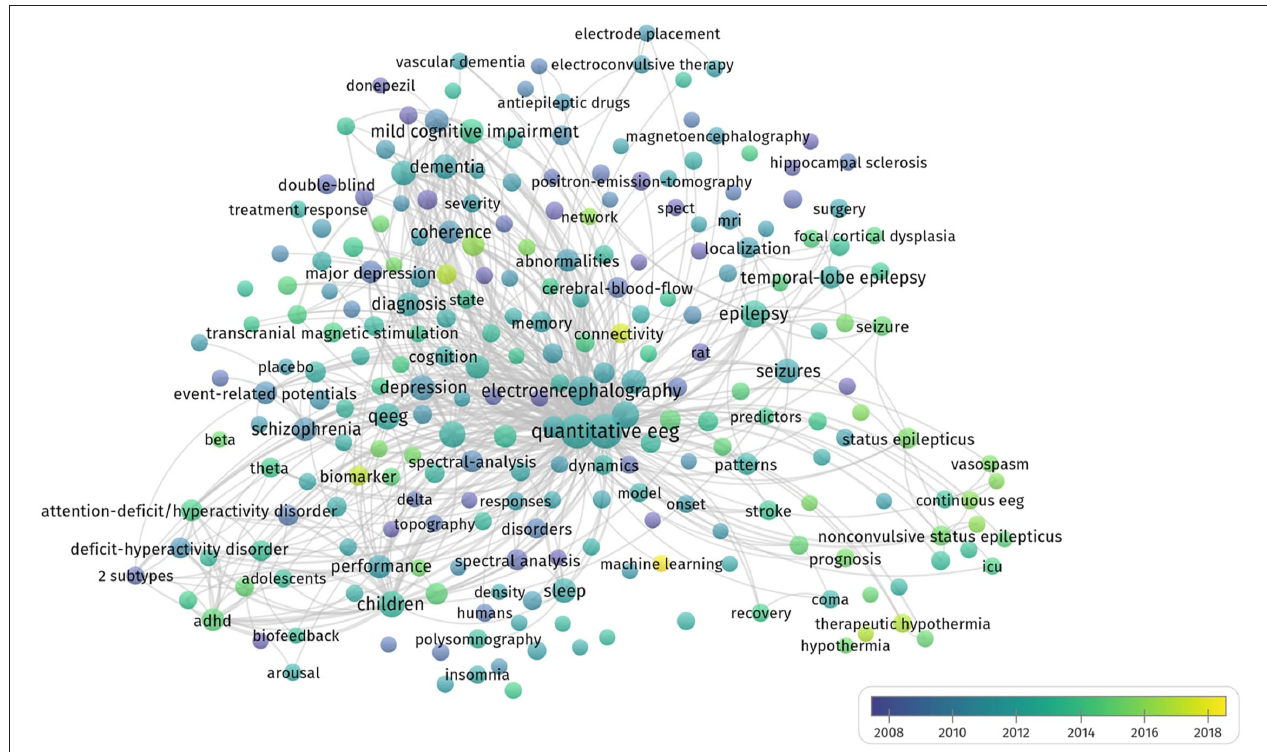
FIGURE 7 | The overlay